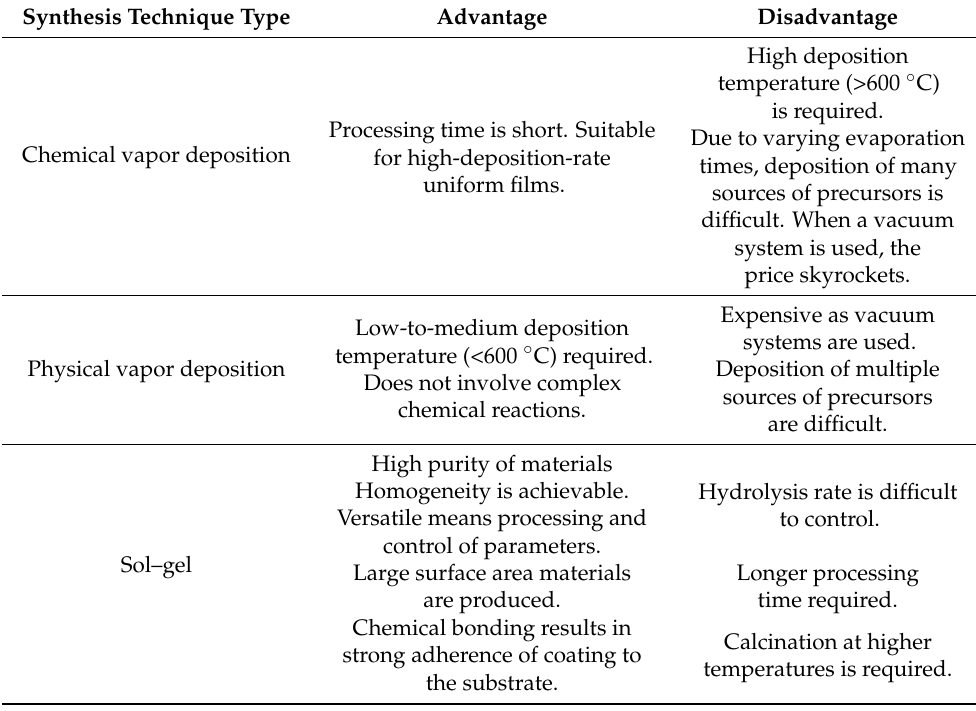
Table 7. Advantages and disadvantages of different methods used for immobilizing TiO 2 photocata- lysts